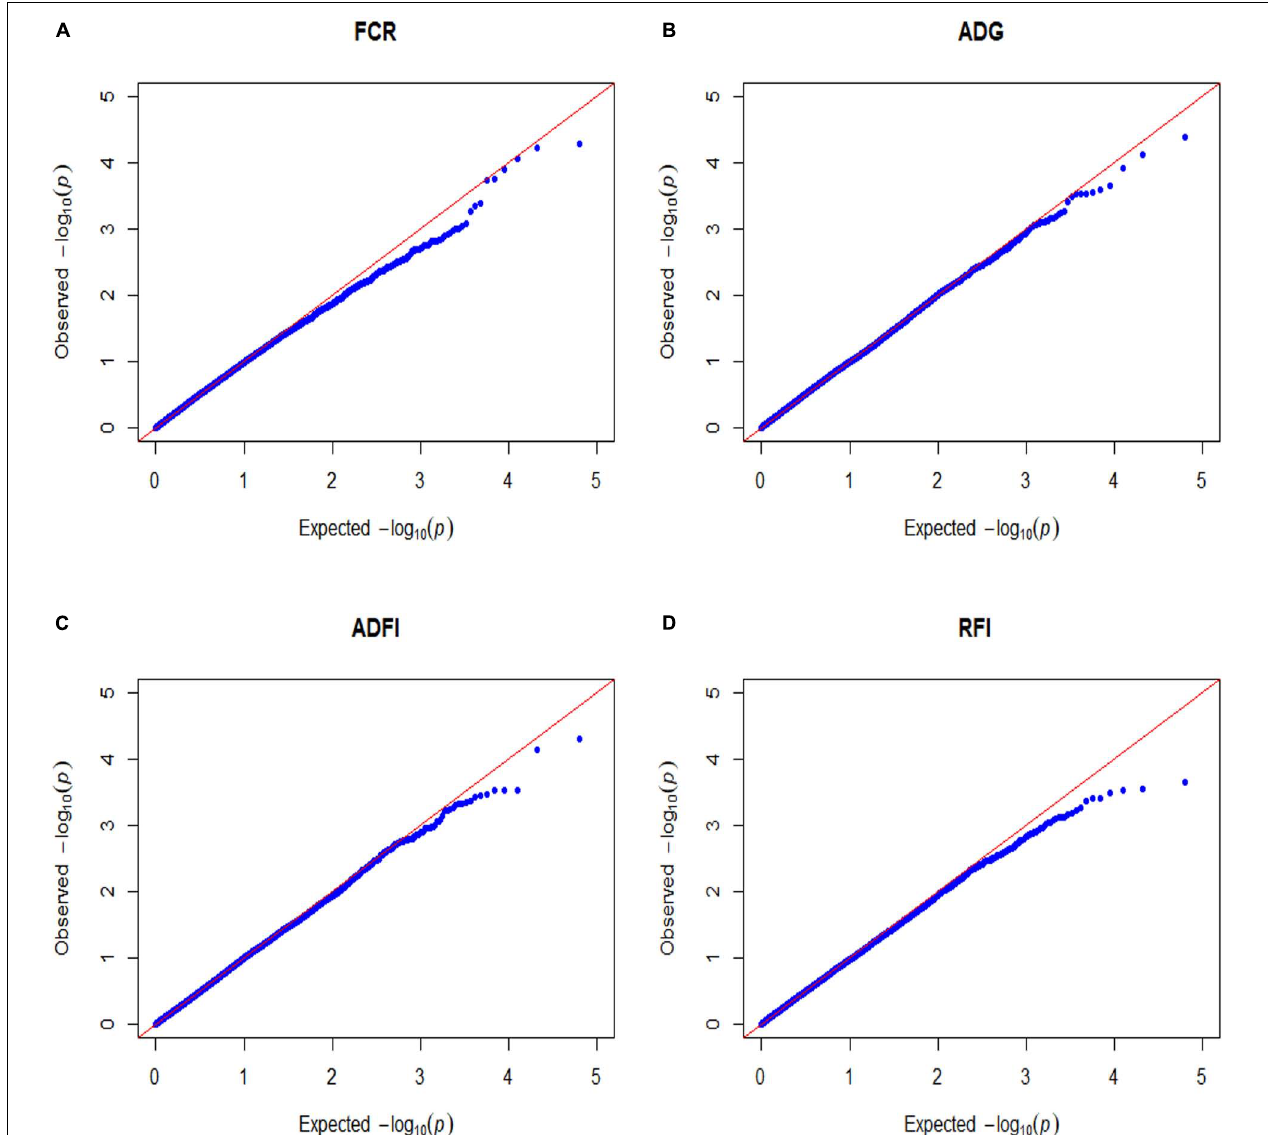
FIGURE 1 | Quantile–quantile plots of GWAS for four feed efficiency traits in a Landrace population. FCR, Feed conversion ratio; ADG, Average daily gain; ADFI, Average daily feed intake; RFI, Residual feed intake. The x -axis and the y -axis represent the expected and observed -log 10 ( P -value). (A) FCR. (B) ADG. (C) ADFI. (D)